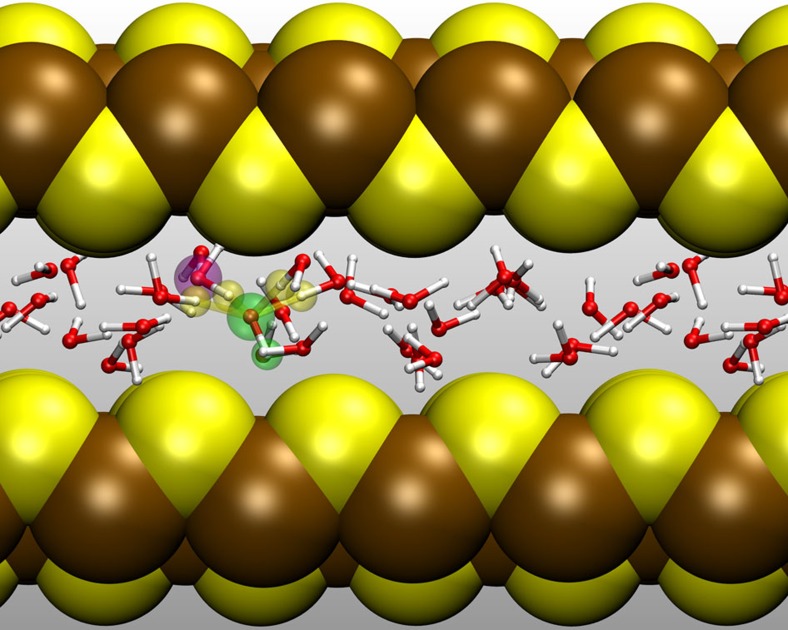
Solvated OH− in the narrow slit pore system N.The mackinawite Fe and S atoms are shown as large brown and yellow spheres, whereas O and H atoms are represented in terms of red and white balls-and-sticks, respectively. The OH− defect is in its hypercoordinated resting state and assumes the preferred perpendicular orientation of its O–H axis with respect to the mineral surface as highlighted using large green spheres for O* and H′; the four H bonds accepted by O* are distinguished using yellow spheres and the Õ atom is marked by a violet sphere; see Fig. 4f for atom labelling.